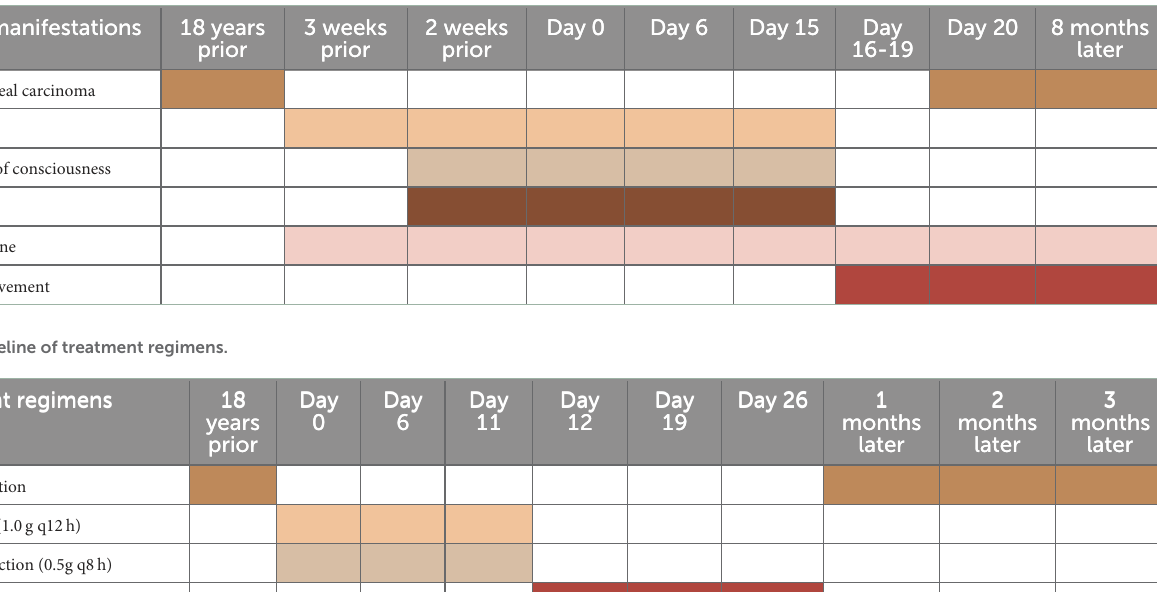
TABLE 1 Timeline of disease manifestations.